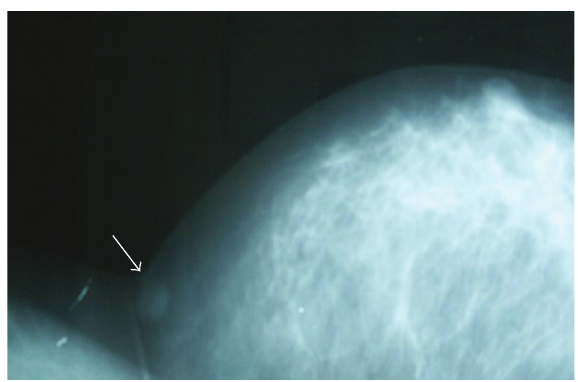
Figure 3: Eosinophilic granular cells with vesicular nuclei, promi- nent nucleoli, and in addition intracytoplasmic eosinophilic parti- cles surrounded by a clear zone (H&E, × 100).